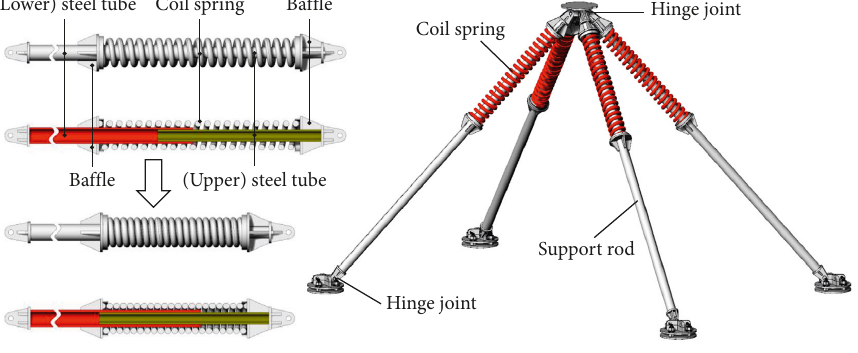
Figure 7: Spring rods.